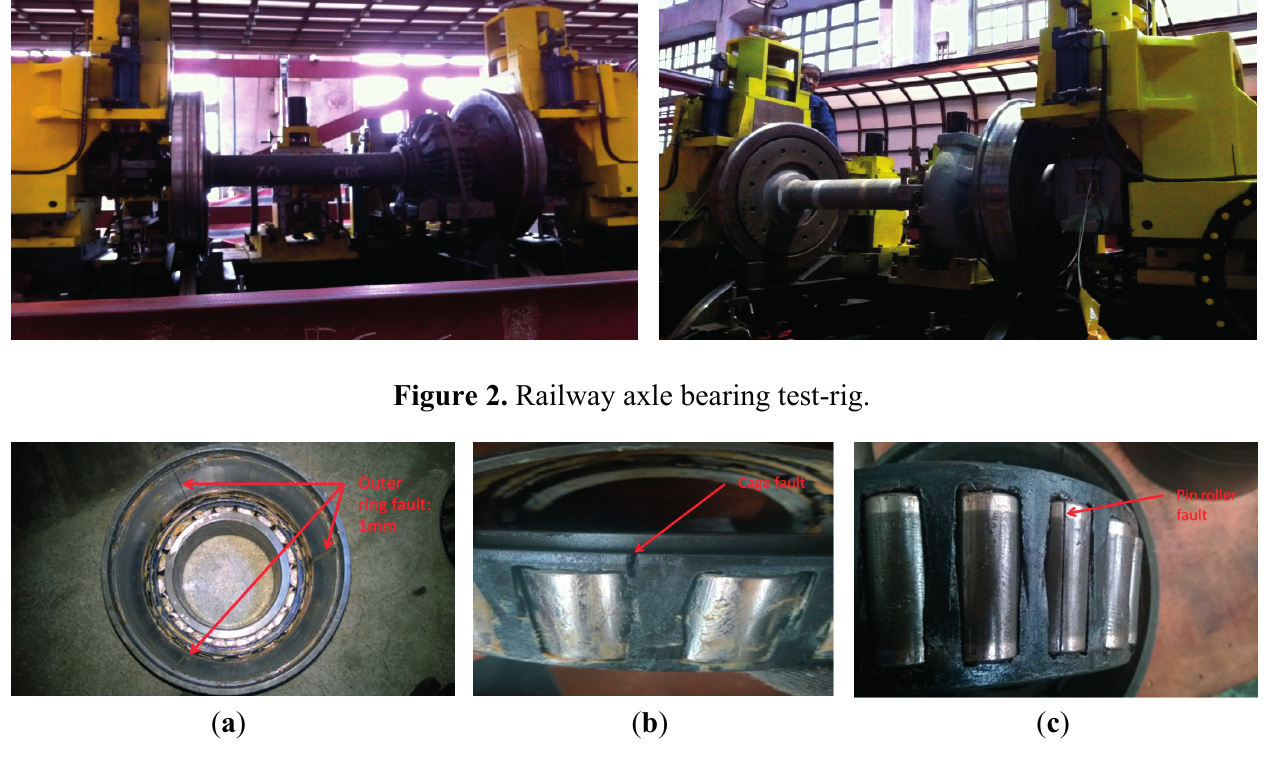
Figure 3. Axle bearing parts with different faults: ( a ) outer ring fault; ( b ) cage fault; ( c ) pin roller